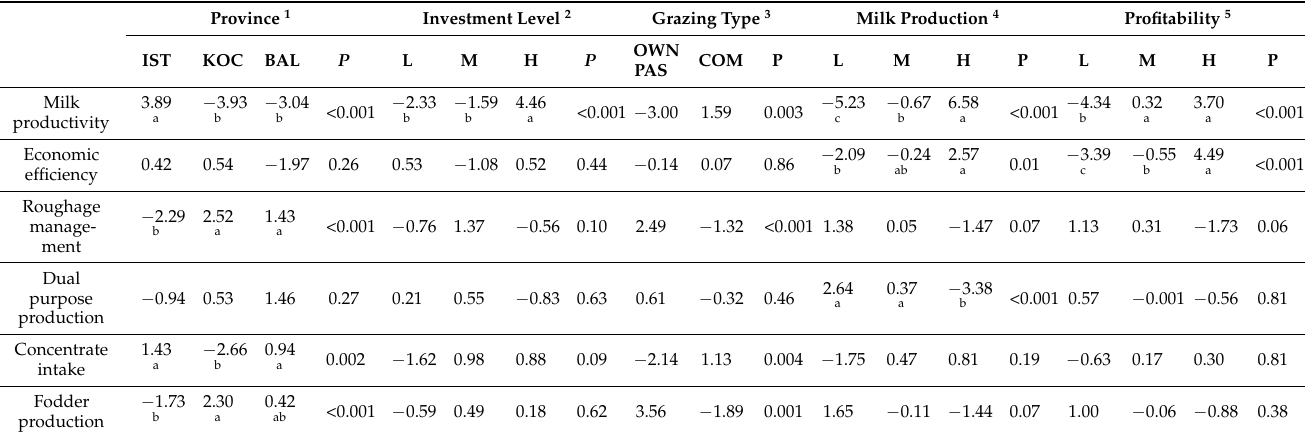
Table 5. The effect of region, investment level, grazing type, milk productivity, and profitability on the 6 extracted